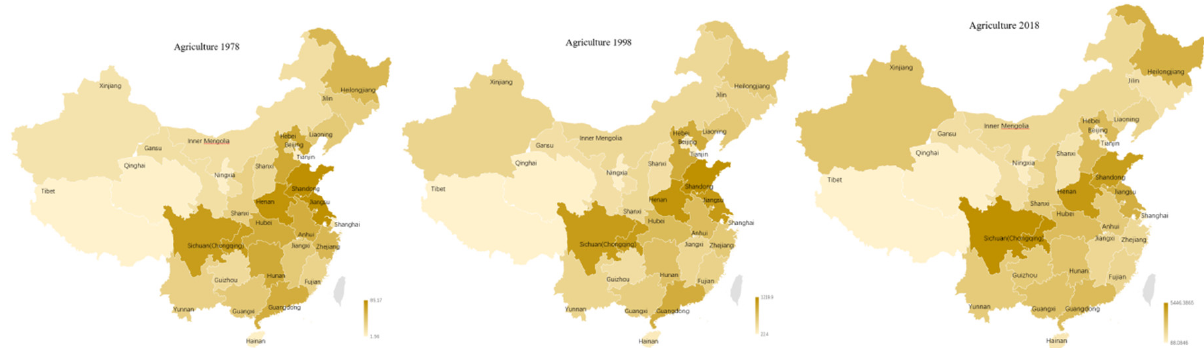
Figure 17. Geographic distribution of farming subsector GDP in 1978–2019.